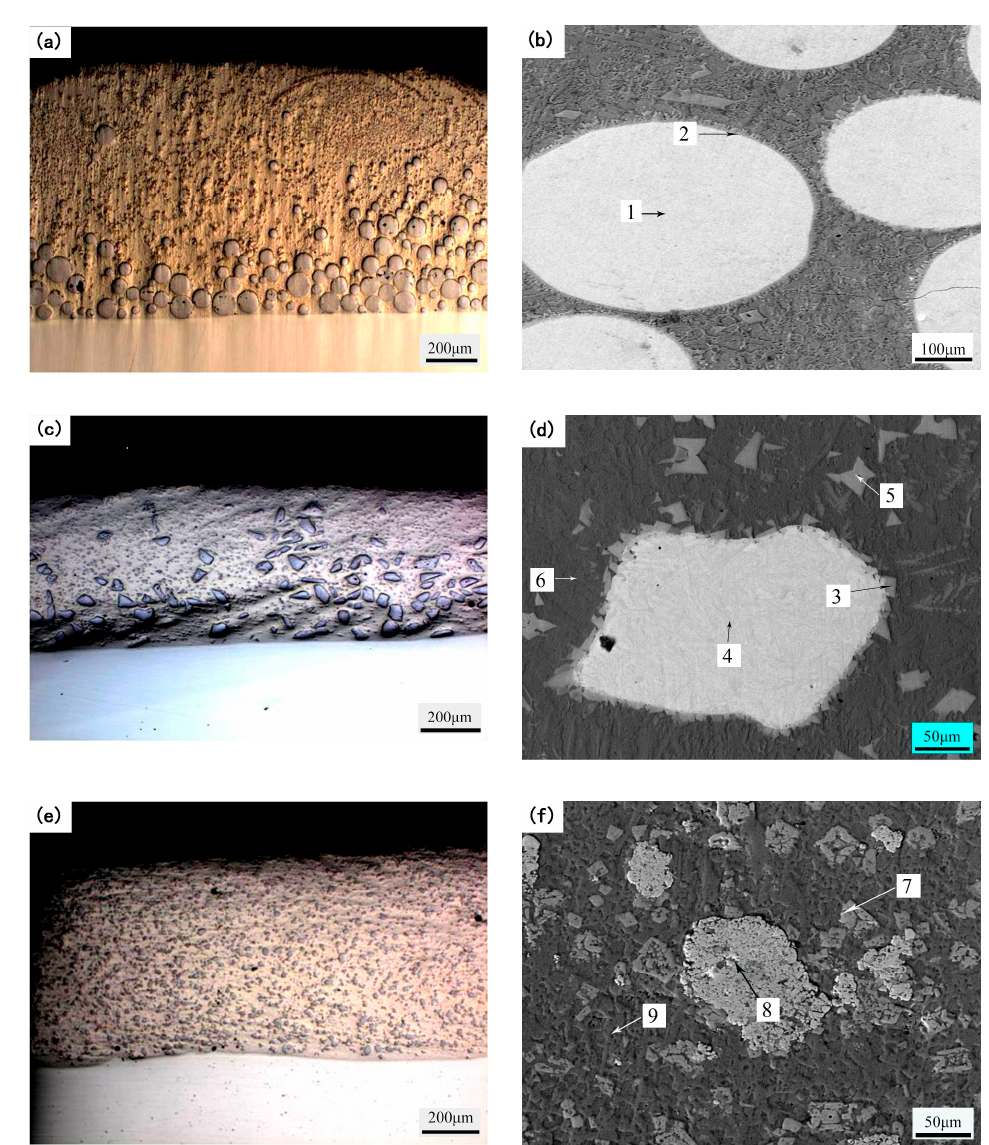
Figure 2. Metallographic microscopy and SEM images of cladding coatings with di ff erent types of WC. Metallographic microscopes of ( a ) Ni60-spherical WC, ( c ) Ni60-shaped WC, and ( e ) Ni60-flocculent WC, and SEM photos of ( b ) Ni60-spherical WC, ( d ) Ni60-shaped WC, and ( f ) Ni60-flocculent